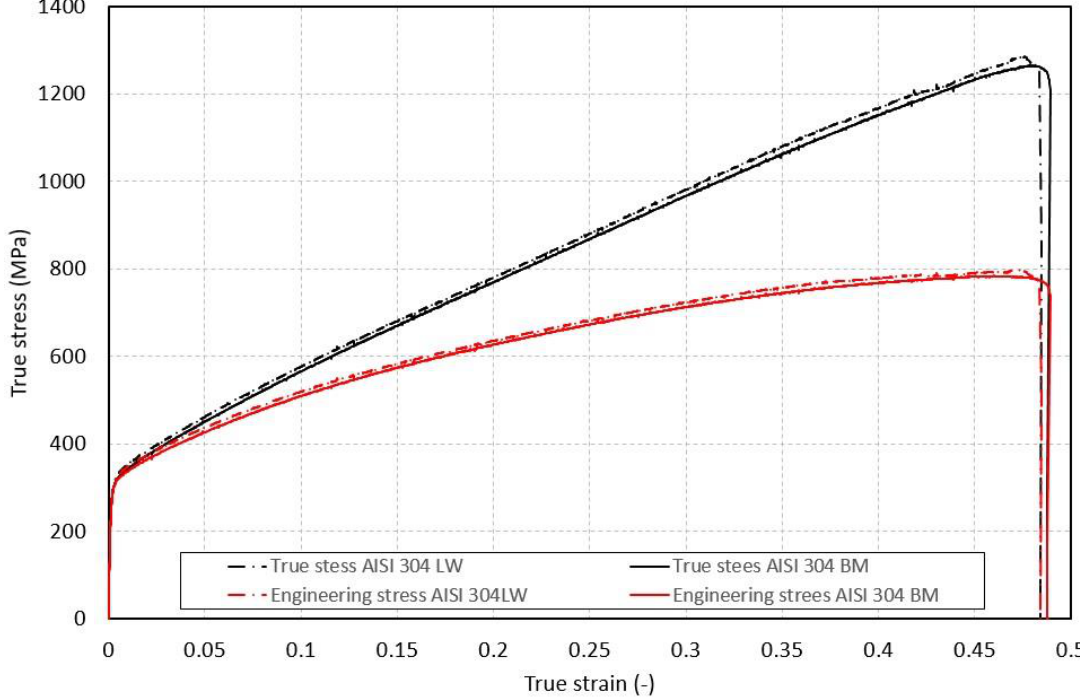
Figure 12. Dependence of the true stress on true strain for AISI 304 BM and AISI 304LW. The welded-joint microstructure (AISI 304 LW) was largely dendritic and showed signs of dendritic growth towards the welded joint centerline, where bilateral dendritic growth terminated (Figure 13a). In the structure of equiaxed austenite grains, there were platelet-like formations in the middle of the welded joint, probably of martensite, formed separately or in bundles (Figure 13b). The microhardness in the area reached 209 HV 0.5. The microstructure of the AISI 304 BM base material was homogeneous and fine-grained,